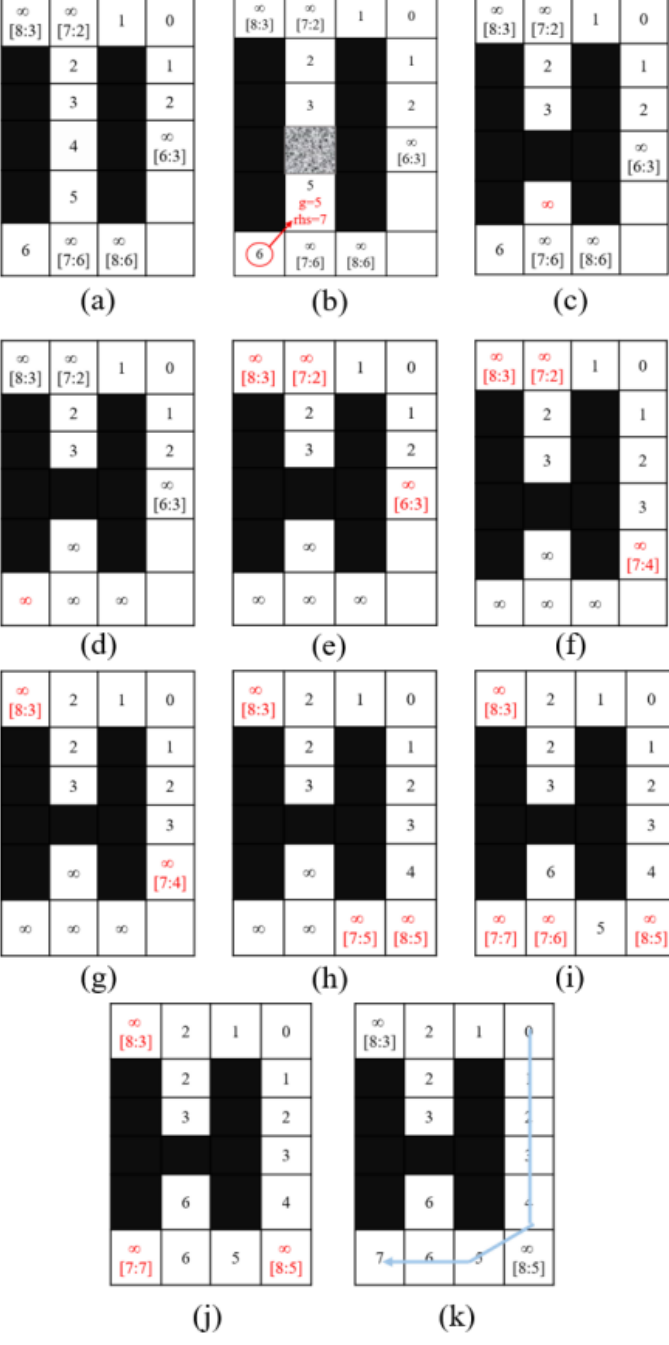
Figure 9. An illustration for incremental update of BICA*.